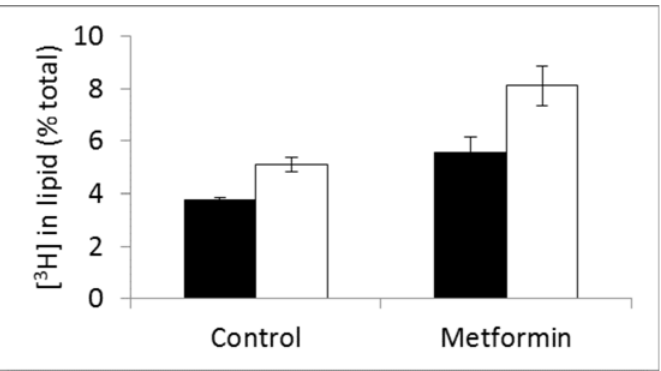
Fig 4. Proportion of [ 3 H-methyl]choline accumulated in the lipid fraction by untreated (control) and metformin-treated MDA-MB-468 breast cancer cells incubated for 4h with the PtdCho-PLC specific inhibitor D609 expressed as a percentage of total cell uptake